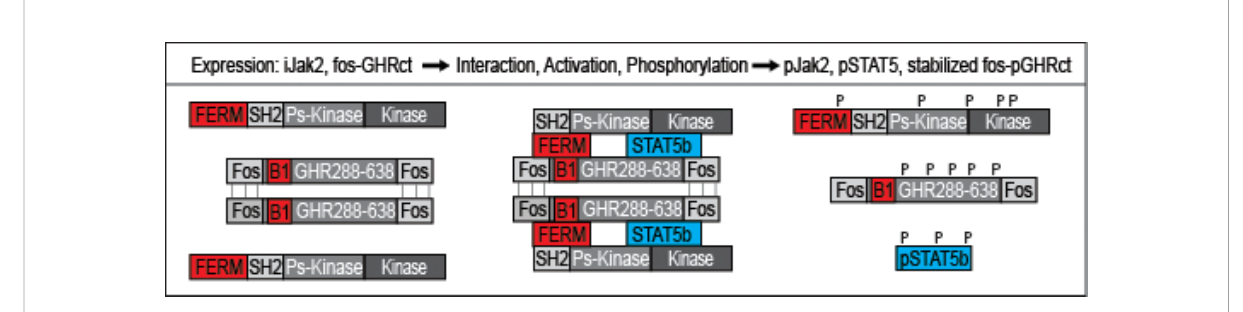
FIGURE 1 Diagram of the primary screen . Depicted are fos-GHRct (amino acid 288-638 with fos zippers (fos), box-1 sequence (B1)), and Jak2 (FERM, SH2, pseudokinase and kinase domains). If fos-GHRct and Jak2 bind via FERM and box-1, Jak2 gets activated and phosphorylates itself, the dimerized fos-GHRct and STAT5b. After phosphorylation of fos-GHRct, Jak2 and STAT5, the complex dissociates. As fos-pGHRct is protease-resistant, it accumulates in the cells. Unphosphorylated fos-GHRct is rapidly degraded. Steady state levels of fos-pGHRct are lower if one of the 6 scenarios is valid. The cell-based assay was performed in g 2A cells carrying inducible Jak2 (iJak2) or binding-de fi cient iJak2 Y119E (as control) ( Figure 2